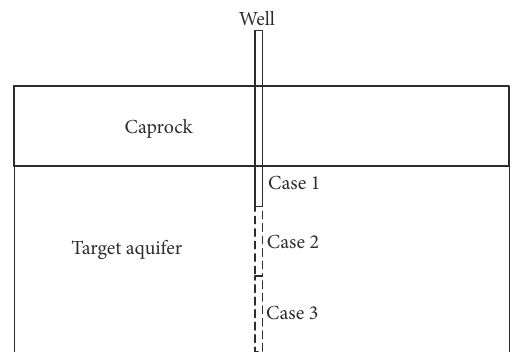
Figure 3: Schematic figure of the three cases with a different penetrating well to the target